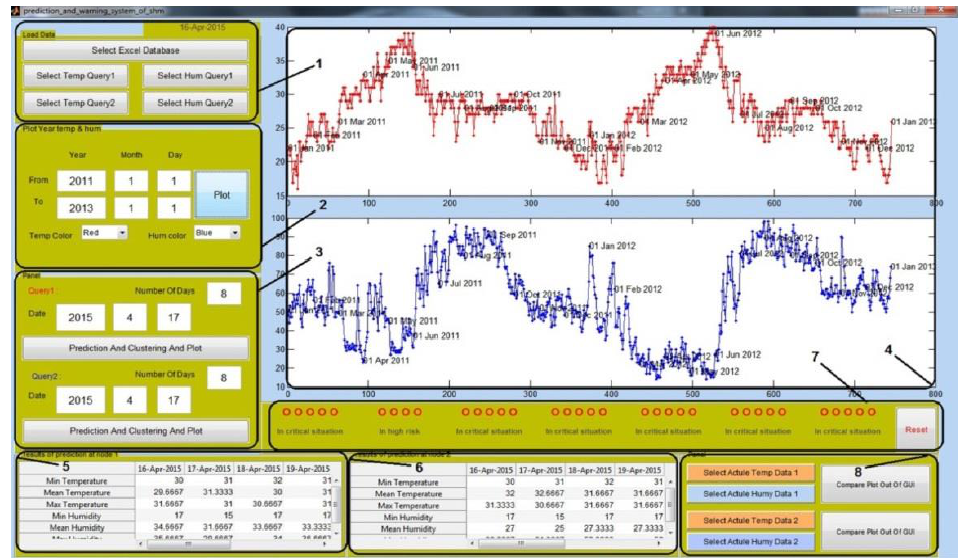
Figure 22. An overview of GUI for temperature and humidity prediction section.